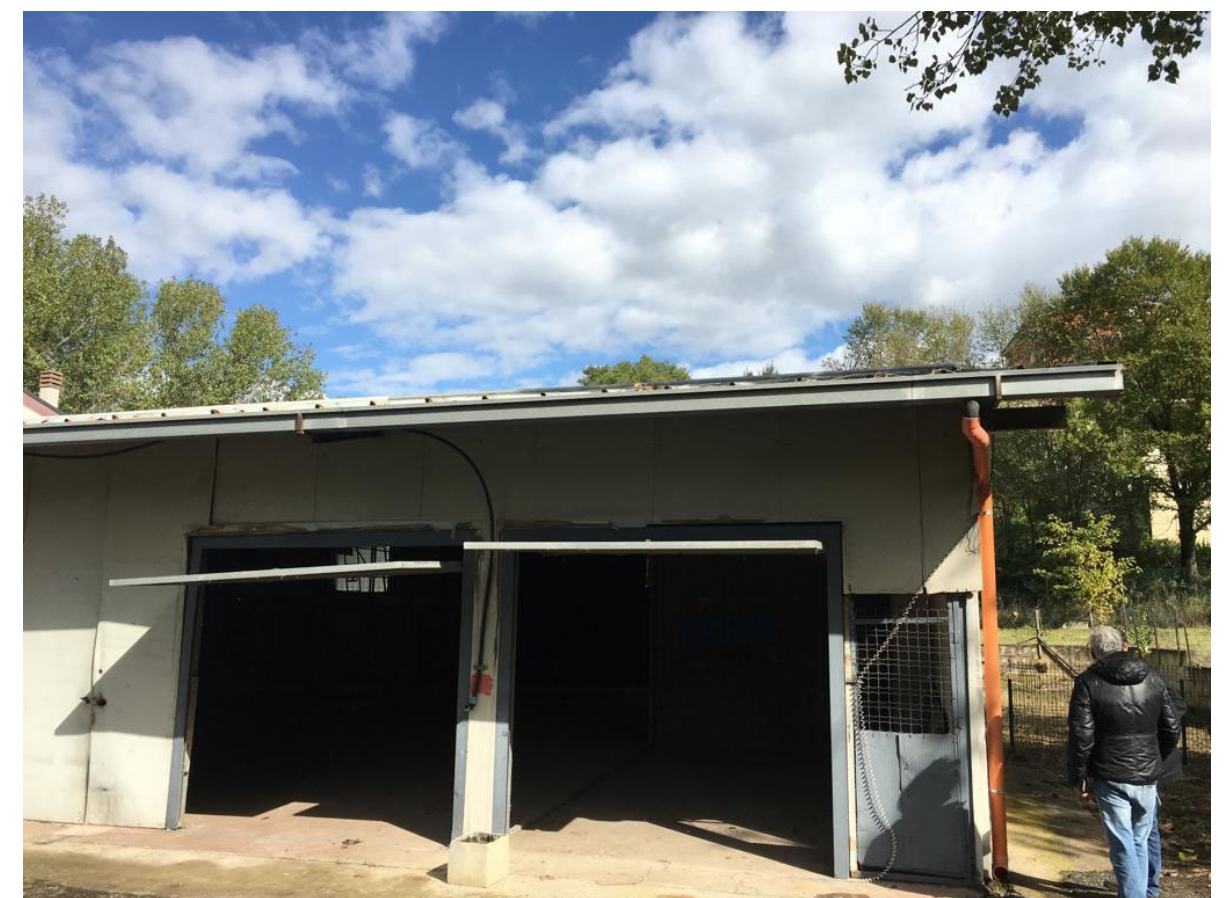
Figure 6. The church of Lunghezza during construction works.